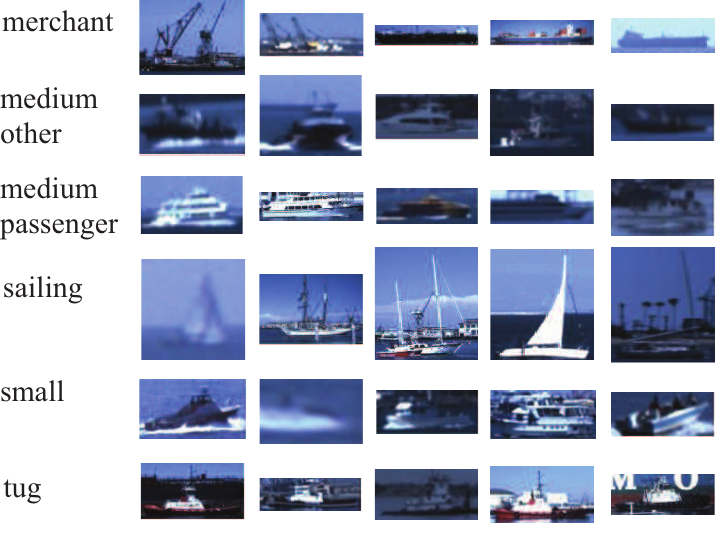
Figure 8. Illustration of the VAIS data. Table 4. Selected classes for evaluation and the numbers of training and test samples using the VAIS data. No. Class Train